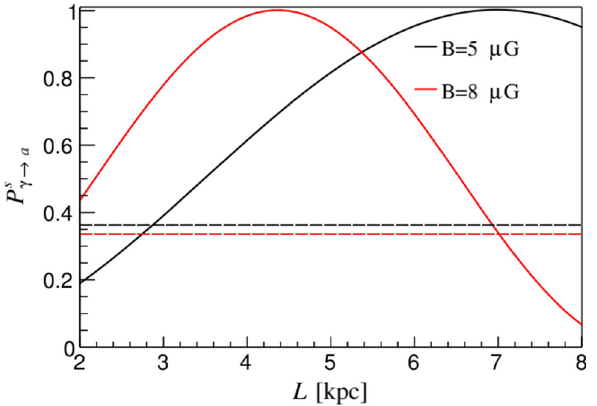
Fig. 5 Average (cid:15) P s γ → a (cid:16) conversion probabilities in the host galaxy at z = 0 as a function of the energy E . We take g a γ = 3 × 10 − 11 GeV − 1 and consider B T = 8 × 10 − 6 G (red curves) and B T = 5 × 10 − 6 G (black curves). The continuous curves are for a single box regular B - field, while the dashed curves refer to the turbulent cell model n e ( z ) = n e , 0 ( 1 + z ) 3